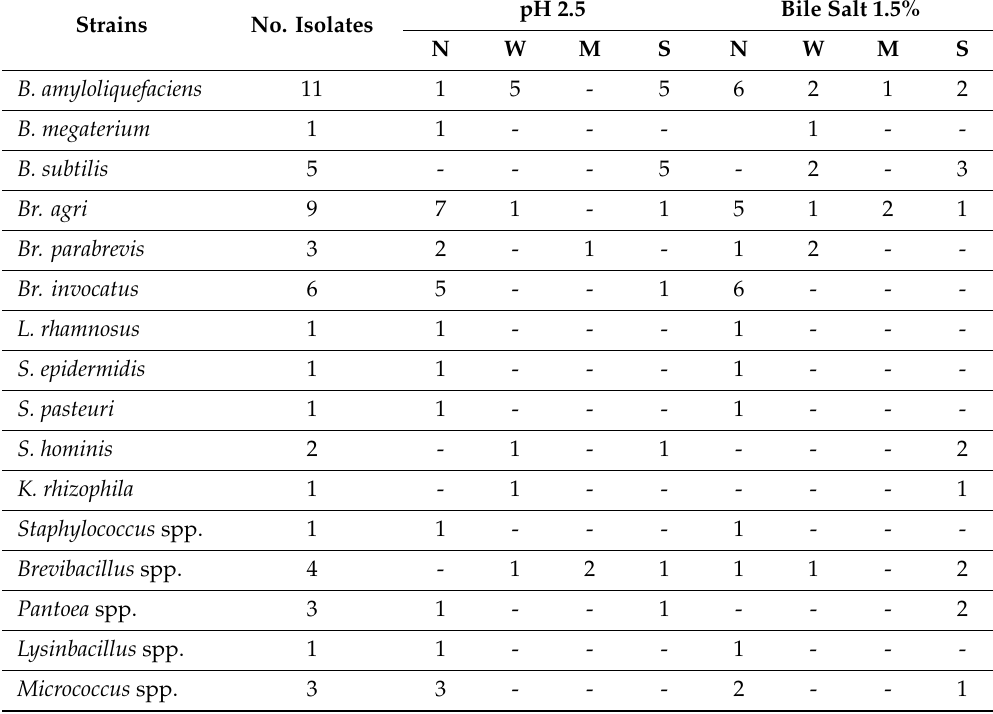
Table 4. Acidic and bile